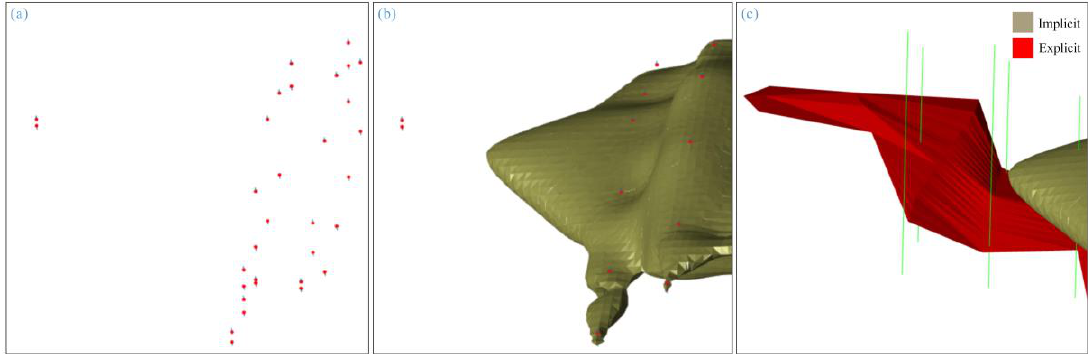
Figure 12. Point Cloud along the Boundary of the Ore Body Area in the West and the Ore Body Model (Case I). ( a ) Point Cloud and Point-Cloud Normal Direction. ( b ) Implicit Model built with the Approach. ( c ) Comparison between the Explicit Model and Implicit Model.